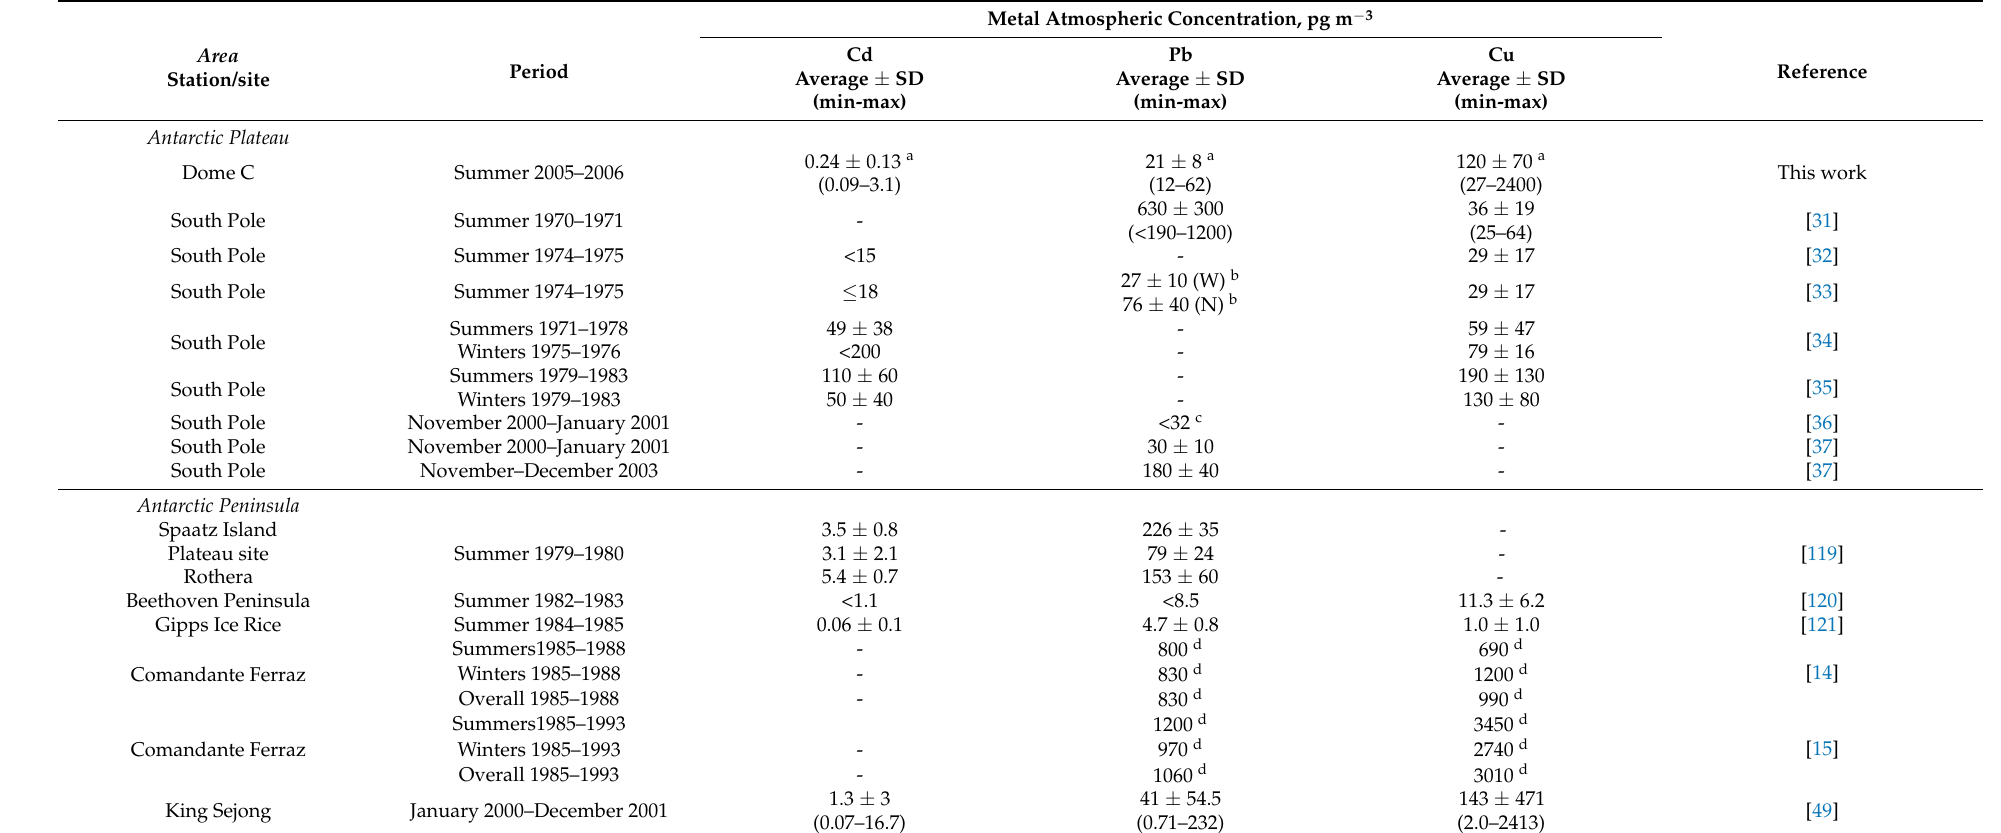
Table 2. Comparison of present results with other Antarctic